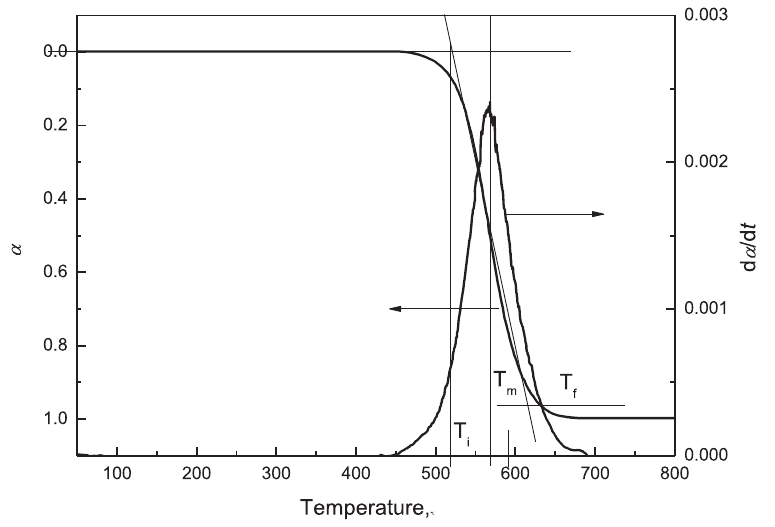
Figure 1: Determine characterization parameter of